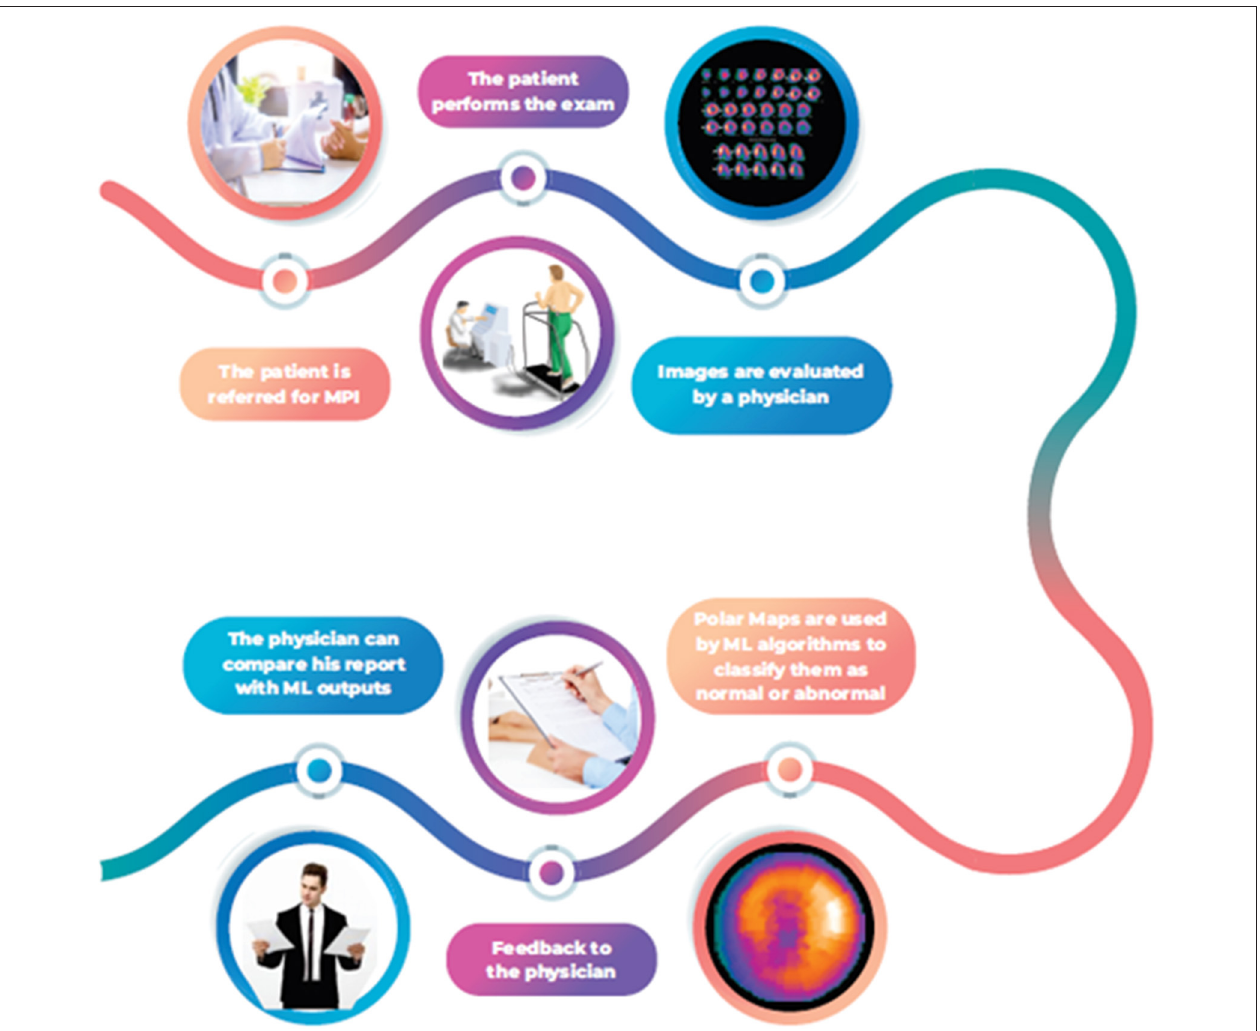
FIGURE 1 | ML algorithms flowchart to support decision making in